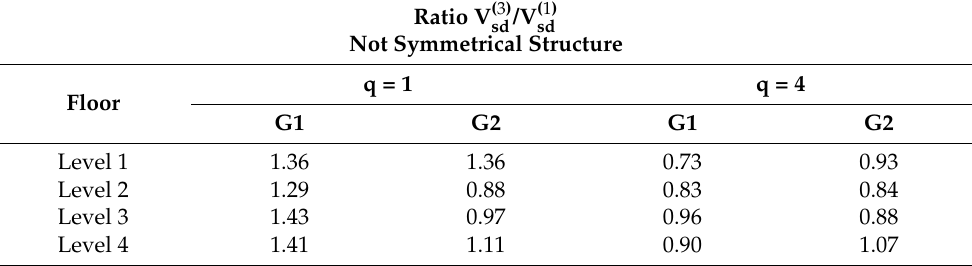
Table 22. Ratios between the shears from the linear dynamic analysis with corrected stiffness and the linear static analysis for all of the multi-storey building case studies with the non-symmetrical disposition of the